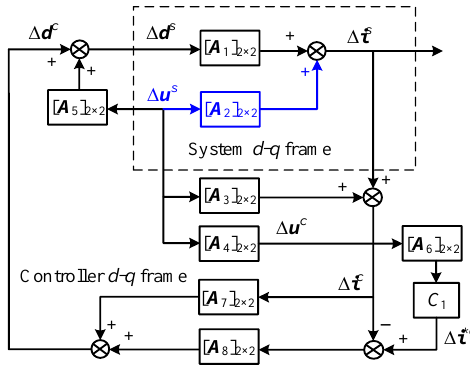
Figure 4. Small-signal model of grid-connected converter with conventional direct power control un- der reverse power flow.